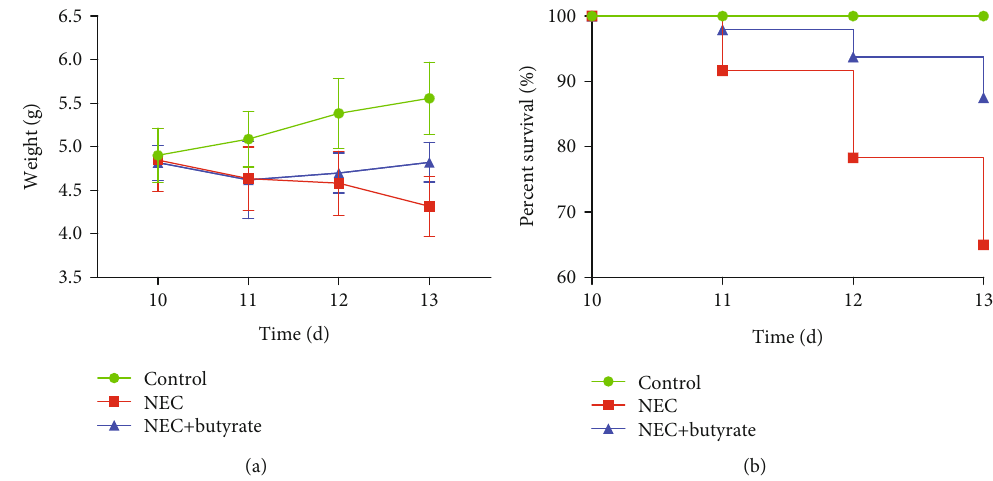
Figure 1: (a) Body weight changes in newborn mice in the three groups. Number of samples: control ( n = 8 ), NEC ( n = 8 ), and NEC +butyrate ( n = 8 ). Statistical analysis: two-way ANOVA multiple comparisons method. (b) Survival curves of newborn mice in the three groups. The survival rate was estimated during modeling, and the results are shown as a Kaplan-Meier plot. Numbers of samples at the beginning: control ( n = 40 ), NEC ( n = 60 ), and NEC+butyrate ( n = 48 ). Statistical analysis: log-rank (Mantel-Cox) test ( P < 0 : 05 ). Control: normal control; NEC: necrotizing enterocolitis; NEC+butyrate: sodium butyrate-treated necrotizing